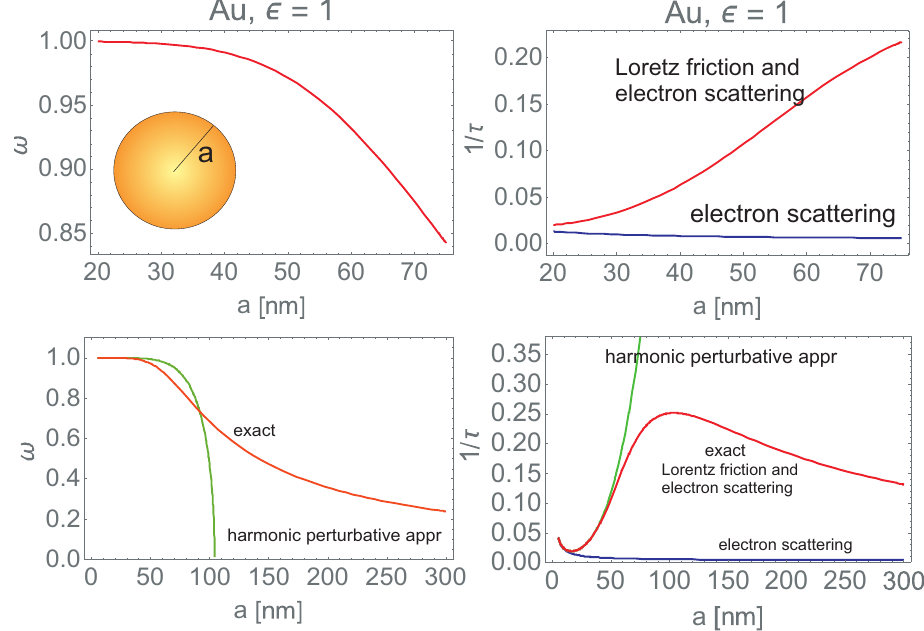
Figure 1. Size dependence of the resonance surface plasmon oscillations (dipole mode) including the Lorentz friction in the metallic (Au) nanoparticle in vacuum for size range, the radius a ∈ ( 20,70 ) nm (upper) and a ∈ ( 5,300 ) nm (lower). The inharmonic oscillation regime (caused by the third order time derivative for the Lorentz friction force [17,18])—red line—is apparently (cf. Equation (1)) strongly different than the harmonic approximation for the Lorentz friction—green line [23,24]. The overdamped regime does not occur in the exact inharmonic oscillations (red curve), whereas the approximate harmonic oscillations stop (green curve) when damping acquires 1 / τ = 1 (the resonance frequency, ω , and the damping rate, 1 / τ , are expressed in dimensionless units, i.e., they are divided by ω 1 ). In blue line it is extracted the electron scattering damping, which occurs much lower than the Lorentz friction losses for a > 20 nm and diminishes with a